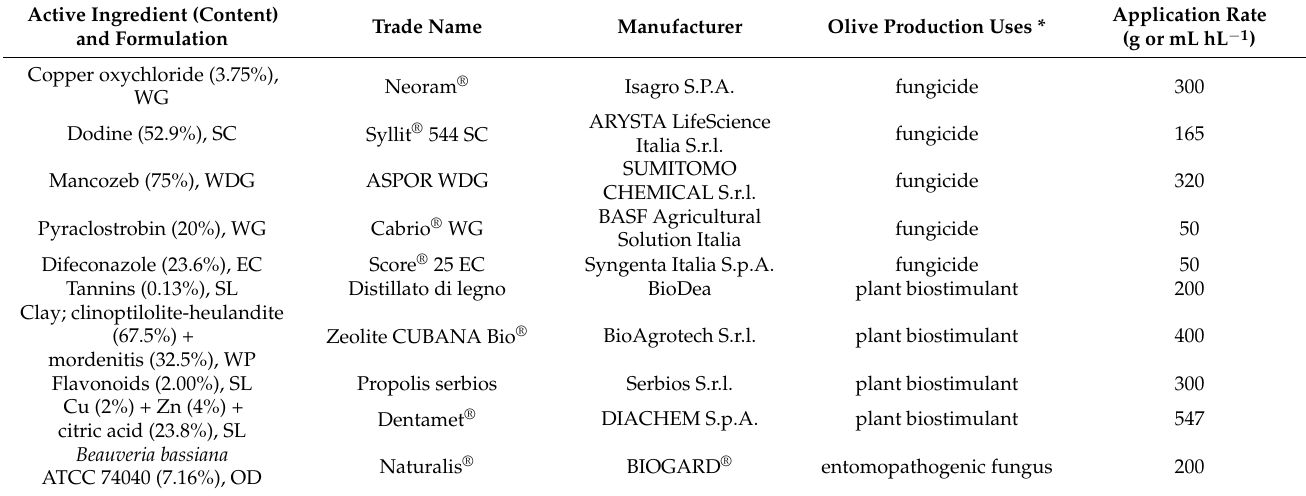
Table 1. Substances used in the oviposition assay (no-choice) and choice